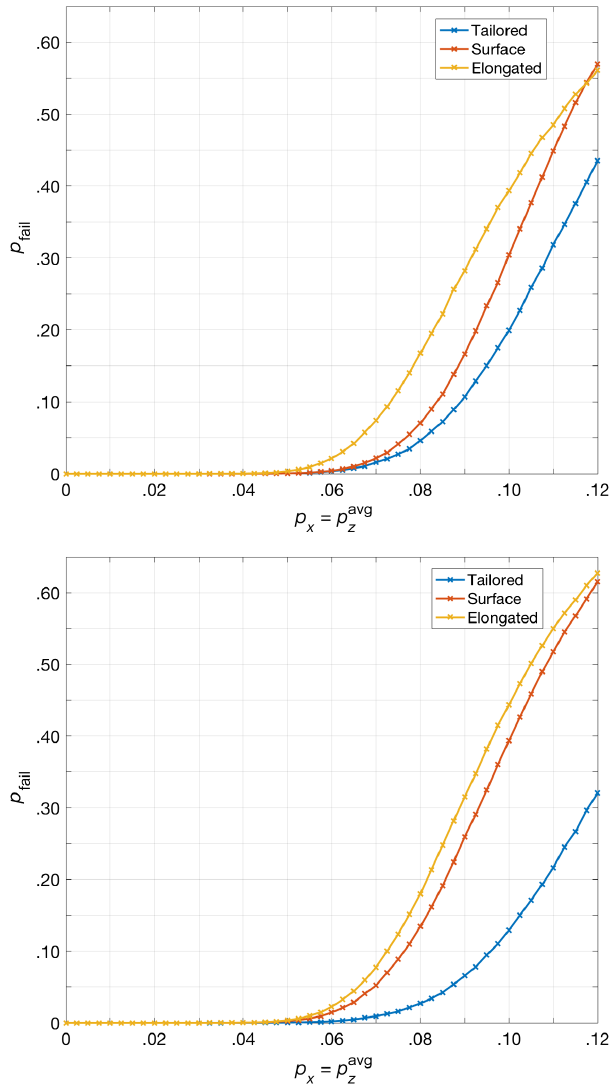
FIG. 7. Error rates for gradually ( w ¼ 0 . 25 , top panel) and steeply ( w ¼ 0 . 10 , bottom panel) inclined linear noise, computed on a lattice of size 33 × 33 using union-find decoding in the high- noise regime. Here, p represents the total probability of a fail failure in either the X - or Z -type